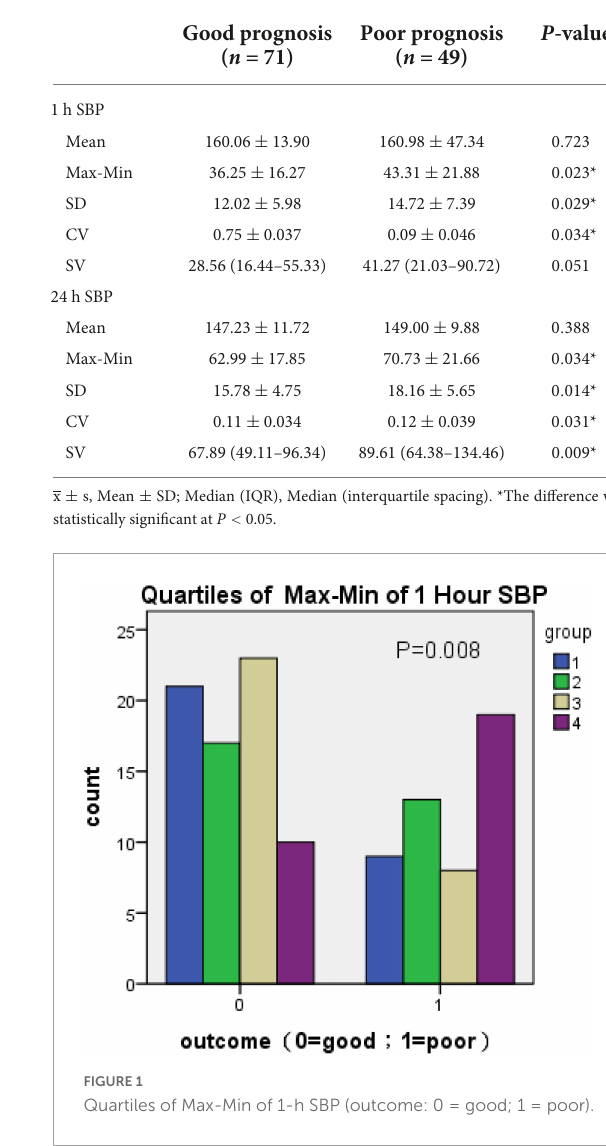
TABLE 2 The effects of BPV on the prognosis of ICH patients.